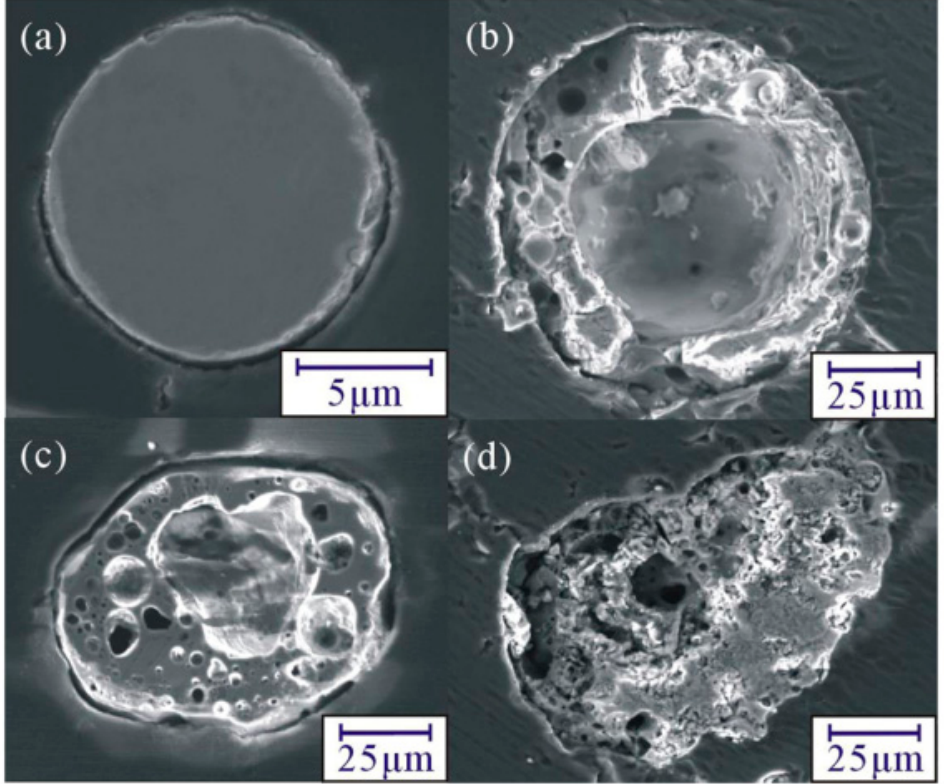
Figure 2. SEM micrographs showing FA structures of ( a ) solid spheres, ( b ) hollow spheres, ( c ) porous spheres and ( d ) irregular particles [51].